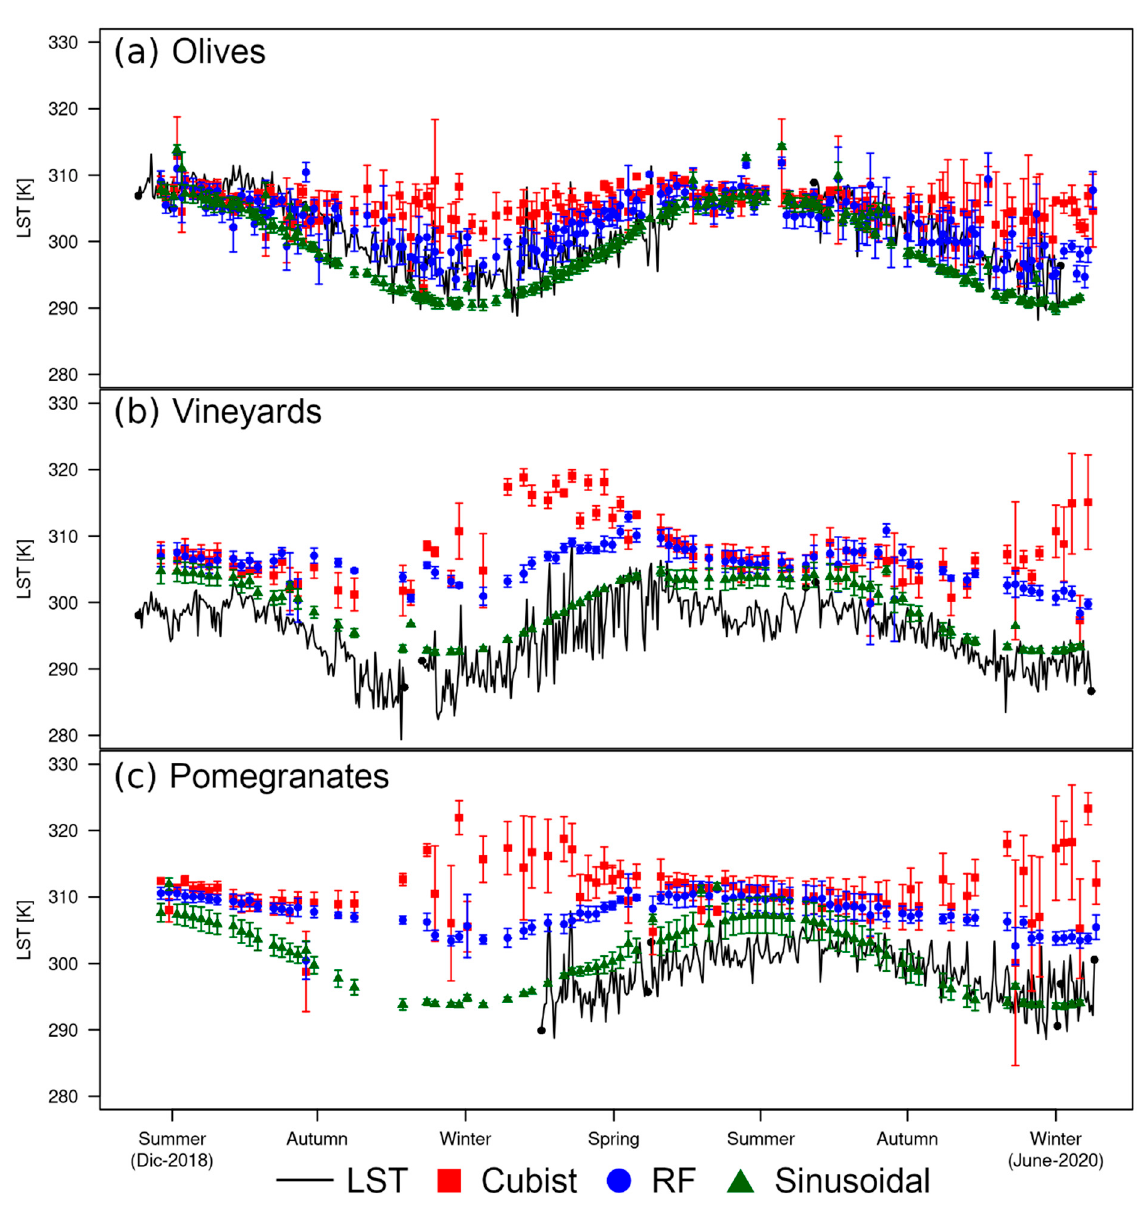
Figure 4. Temporal series of the predicted Sentinel-2 LST at 100 m of the cubist, random forest, and sinusoidal models compared to the LST measured by the in situ stations at ( a ) olives, ( b ) vineyards, and ( c ) pomegranates orchards. The error bars are showing the standard deviation of the 9 pixel cells surrounding the LST station of each LST model.